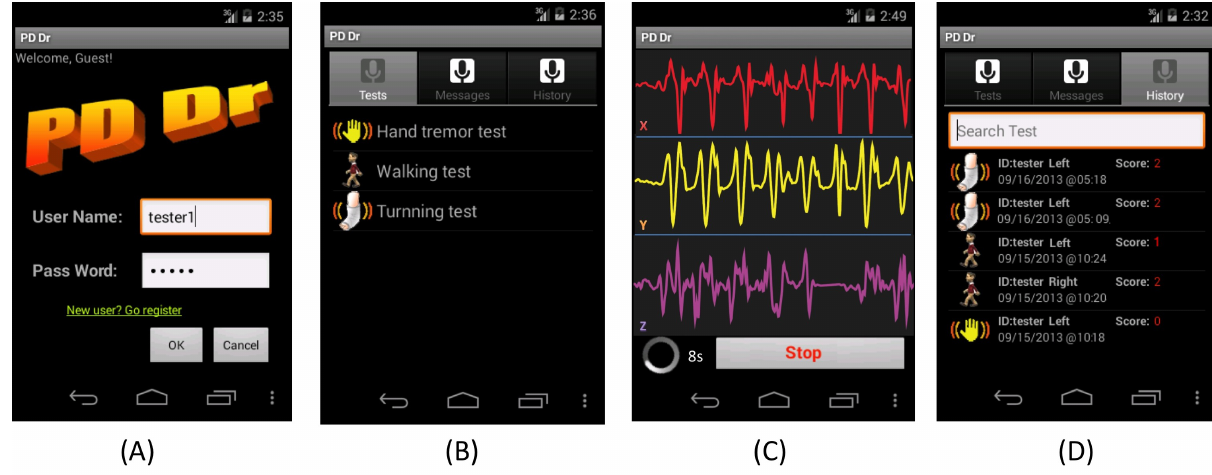
Figure 3. Screenshots of PD Dr app: (A) User account log-in, (B) Motor test list, (C) Data collection during test, and (D) Test history and evaluation